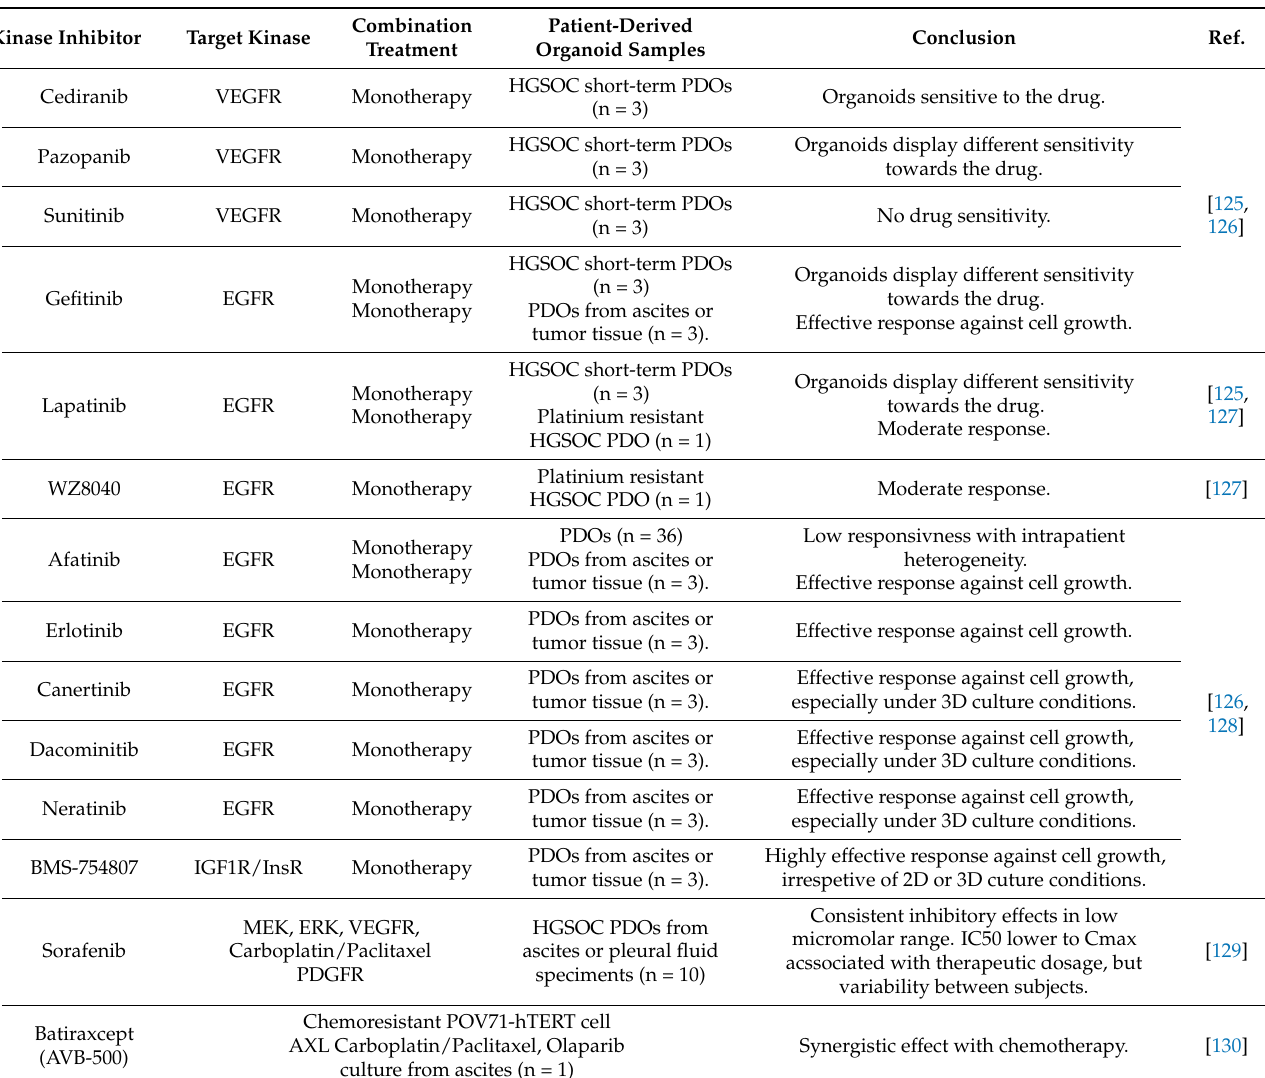
Table 3. Recent kinase inhibitor studies (published after 2017) utilizing ovarian cancer patient organoids and primary cultures isolated mostly from HGSC